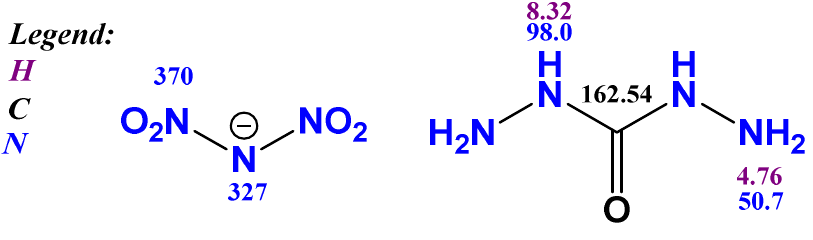
Figure 4. Signal assignment for sample 6.